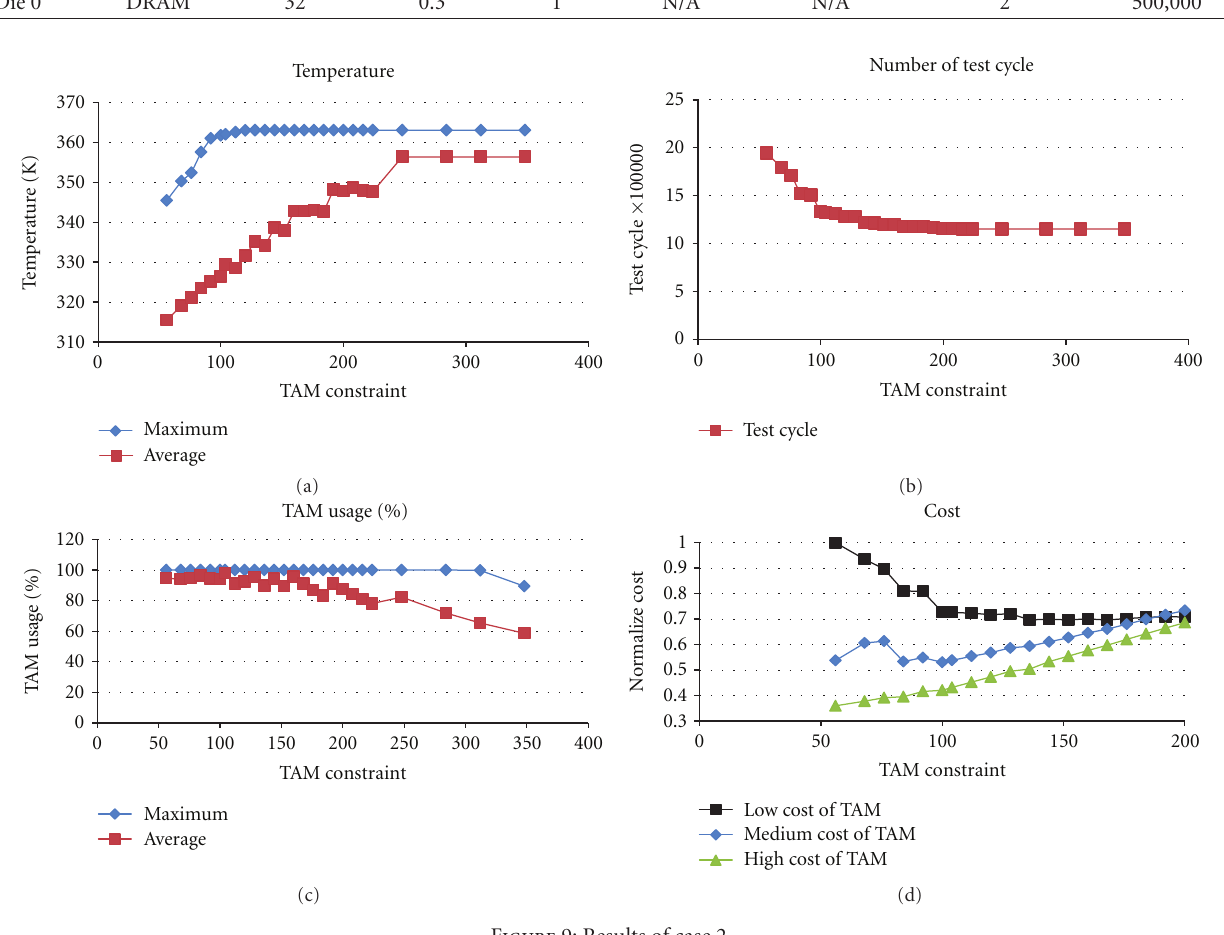
Figure 9: Results of case